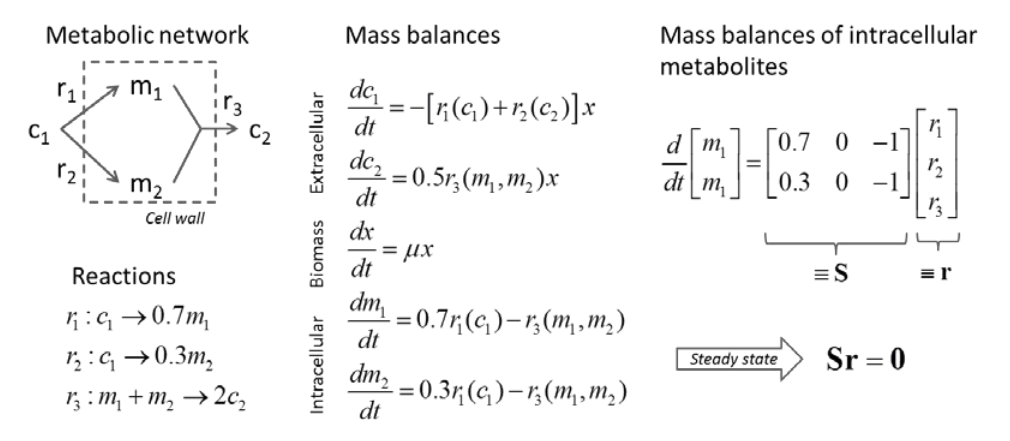
Figure 3. Graphical and mathematical representations of metabolic reactions occurring in a